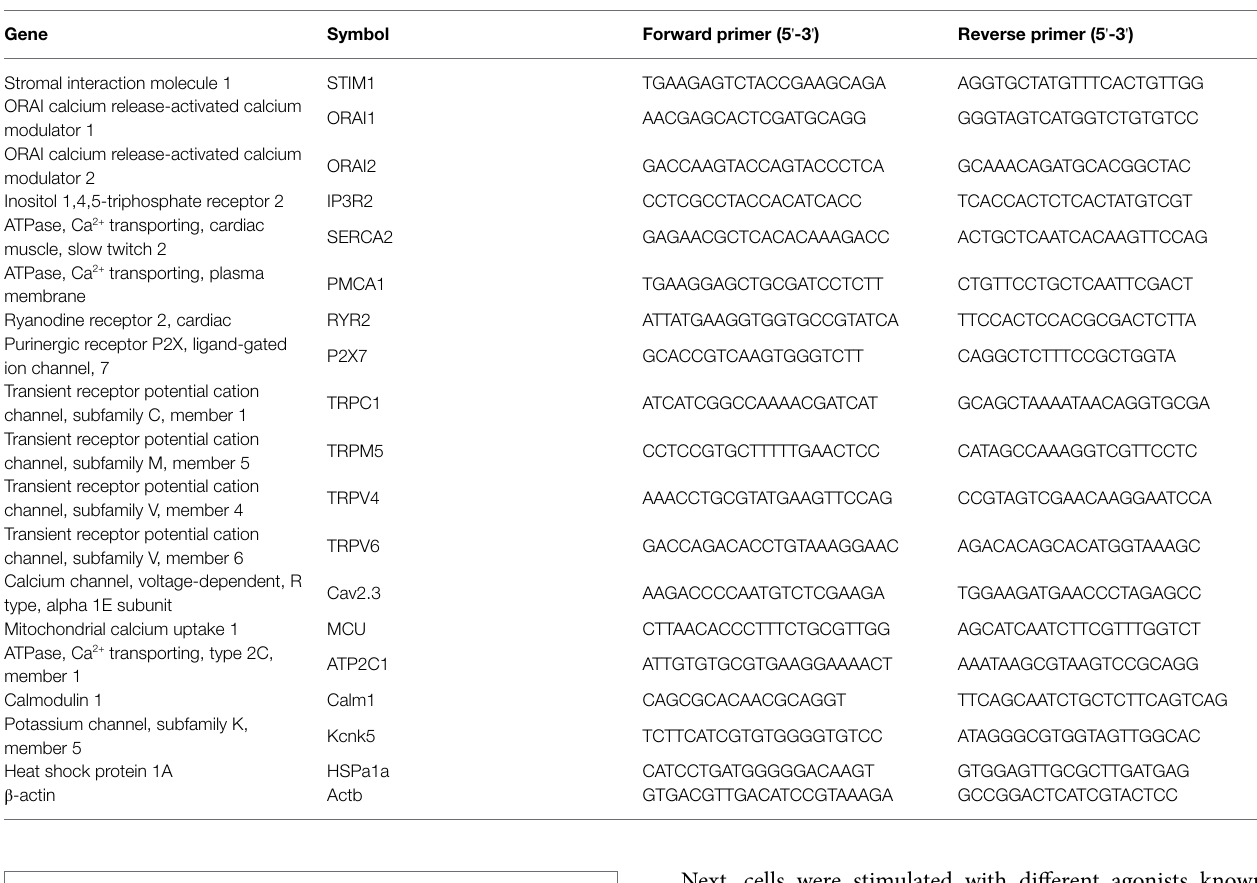
TABLE 1 | List of primers for quantitative PCR.